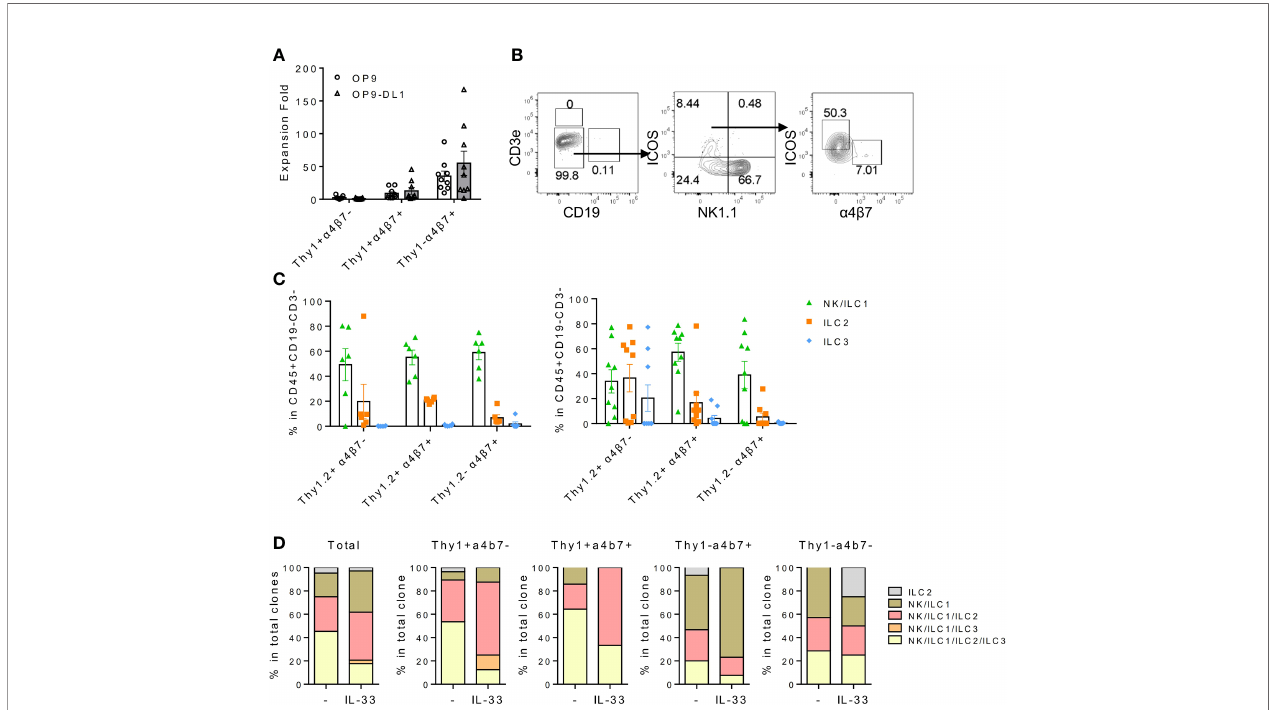
FIGURE 2 | IL18Ra + BM progenitor cells contain multipotent ILCPs. (A – C) In this study, 200~500 cells from Thy1 + a 4 b 7 - , Thy1 + a 4 b 7 + , and Thy1 - a 4 b 7 + subsets from the BM IL-7R a + IL-18R a + population were FACS-sorted and cultured on OP9 or OP9-DL1 stromal cells with 20 ng/ml SCF and 20 ng/ml IL-7 for 12 – 14 days. (A) Expansion fold of the three subsets after culture. (B) Representative FACS plot showing the generated ILCs after culture. (C) Percentage of NK/ILC1, ILC2, and ILC3 in CD45 + cells generated from Thy1 + a 4 b 7 - , Thy1 + a 4 b 7 + , and Thy1 - a 4 b 7 + subsets cultured on OP9 (left) or on OP9-DL1 (right). (D) In vitro differentiation of index-sorted single BM lin - IL-18R a + IL-7R a + cells on OP9-DL1 for 14 – 16 days. Sixty-four out of 570 clonal progenies cultured without IL-33 (indicated as “ - ” ) and 34 out of 568 clonal progenies cultured with 20 ng/ml IL-33 (indicated as “ IL-33 ” ) were analyzed. Data are representative of three or more independent experiments with six mice in each group in panels (A, C) The data are presented as mean ± SEM in panels (A, C)